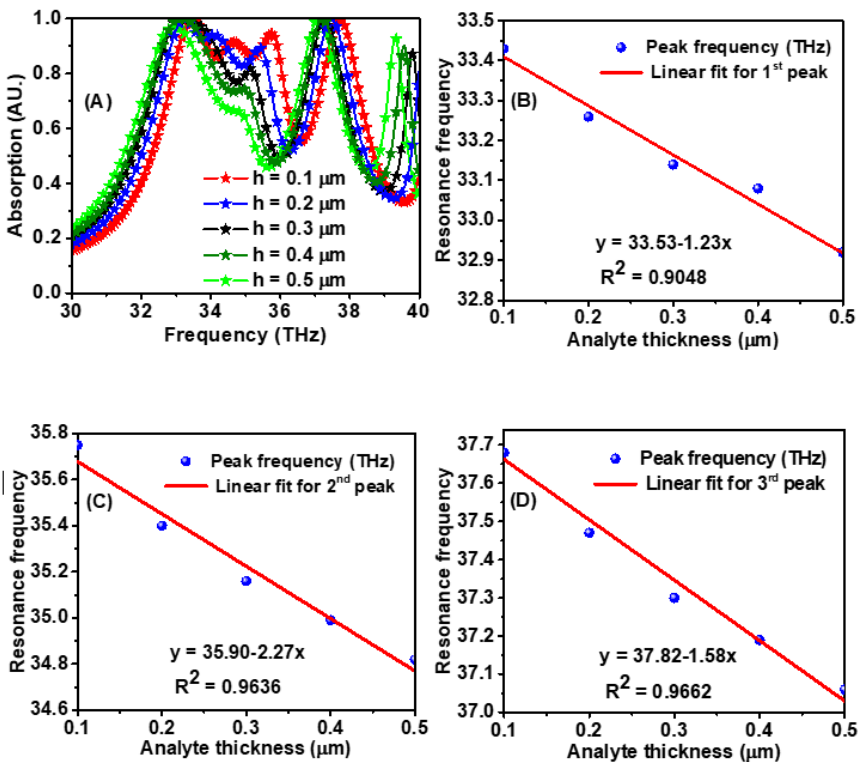
Figure 8. ( A ) Absorption spectrum dependence on the variation of analyte depth and ( B – D ) shows the frequency shift versus different analyte depths for the three resonance frequencies.